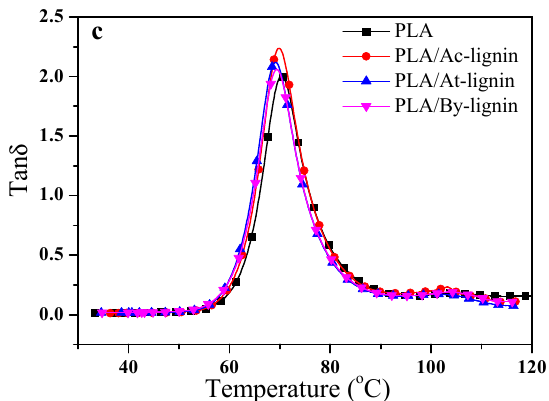
Figure 11. Dynamic mechanical properties of PLA and PLA-lignin biocomposites: ( a ) Storage modulus, ( b ) loss modulus, and ( c ) tan δ .